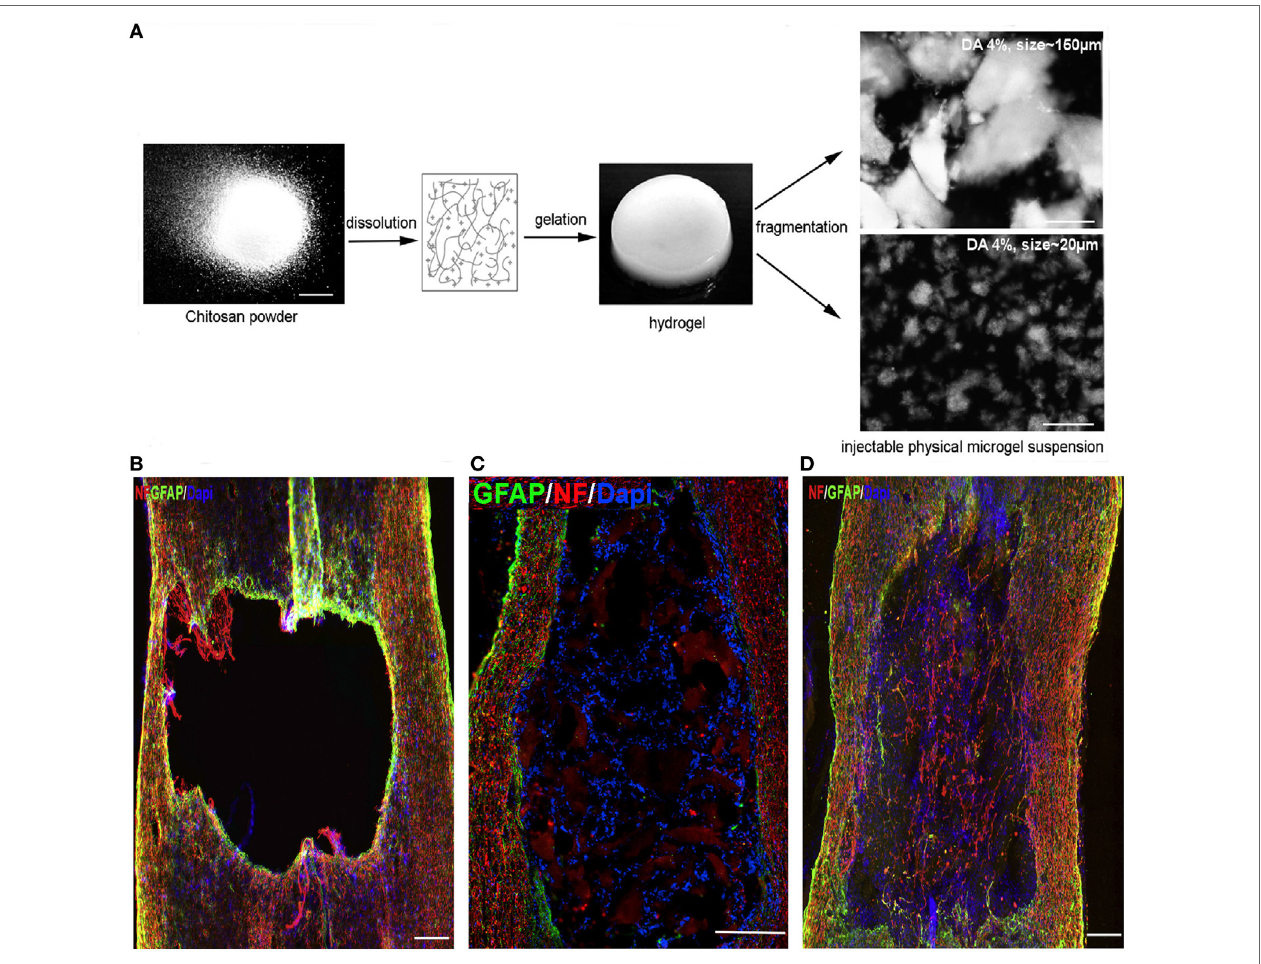
FiGURe 1 | (A) Chitosan solution gelled by contacting with ammonia vapors and then fragmented mechanically into differing average microscale architecture. (B–D) Immunostaining of spinal cord lesion site 4 weeks postinjury/injection for neurofilament (NF), astrocytes (GFAP), and cell nuclei (DAPI). (B) Lesion only, (C) lesion with chitosan-FPHS hydrogel implant with 150-µm average fragment size, and (D) lesion with chitosan-FPHS 20-µm average fragment size. Smaller fragments result in greater presence of NF in the lesion site. (B,D) Scale bar = 240 µm and (C) Scale bar = 300 µm. Reproduced with permission of Chedly et al. (2017), Copyright 2017,